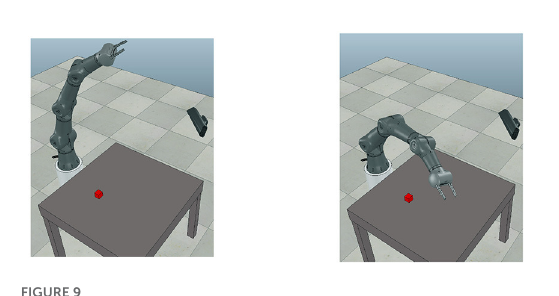
FIGURE9 Examples of different initial positions of Torobo Arm in extended dataset. FIGURE10 Clustering results for entire trajectories in extended dataset. All 4,725 samples are presented in order of consecutive 675-element batches, in which every batch is a collection of motions belonging to the same